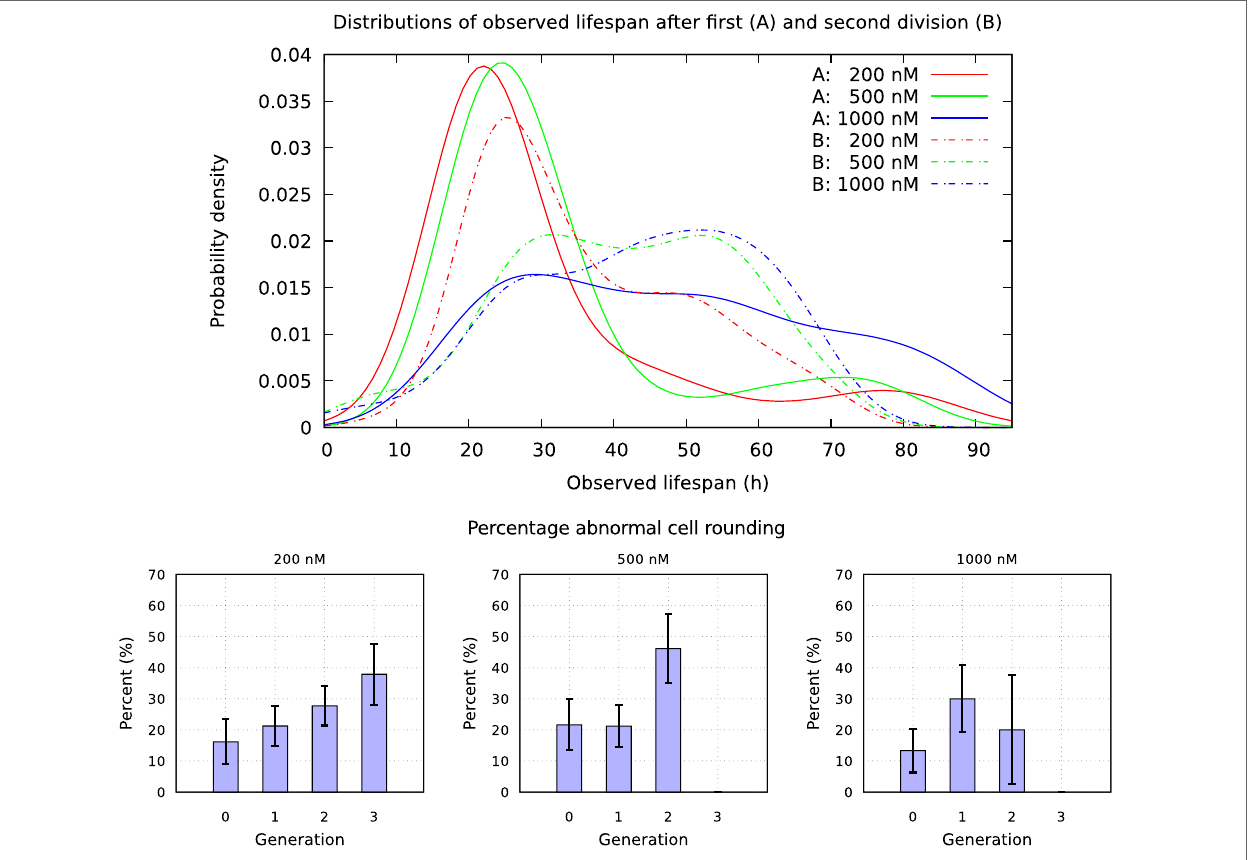
FigUre 17 | Upper part: distribution of observed life span for cells exposed to YTX at concentrations 200, 500, and 1,000 nM after first and second division. Lower part: fraction of mitosis events without proper cellular rounding. Note that this fraction roughly seems to increase for each cell cycle. A cell is here formally defined to “round up” if the radius of the maximum disk included in/inside (the image of) the cell and the radius of minimum disk including/covering the cell, differ less than